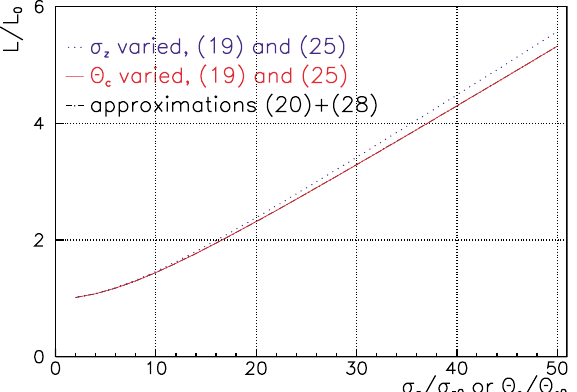
FIG. 3. (Color) Relative increase in VLHC-II luminosity as a function of the relative increase of the product of rms bunch length and crossing angle, s z u , starting from the quasiequilib- rium state between radiation damping and intrabeam scattering [20,21] as estimated for the stage-II VLHC parameters [12], s z (cid:1) 1.5 cm, s (cid:1) (cid:1) 0.7 m m, b (cid:1) (cid:1) 0.71 m, and u (cid:1) 10 m rad, assuming that s (cid:1) remains unchanged, and maintaining a con- stant total beam-beam tune shift for two collisions with alternat- ing crossing. The subindex “0” refers to the initial parameters listed